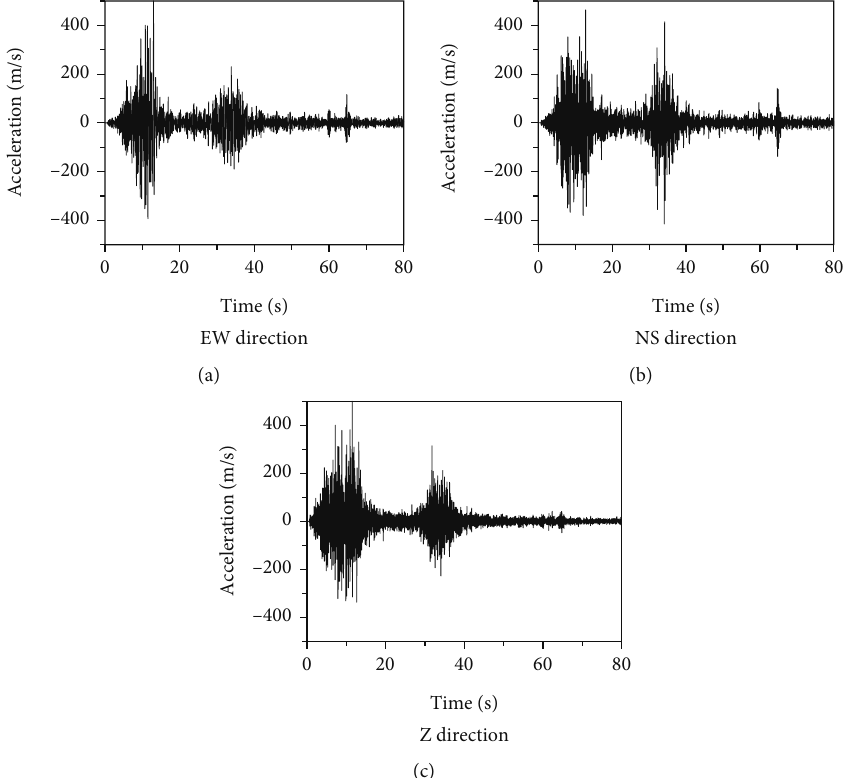
Figure 7: Seismic acceleration time course